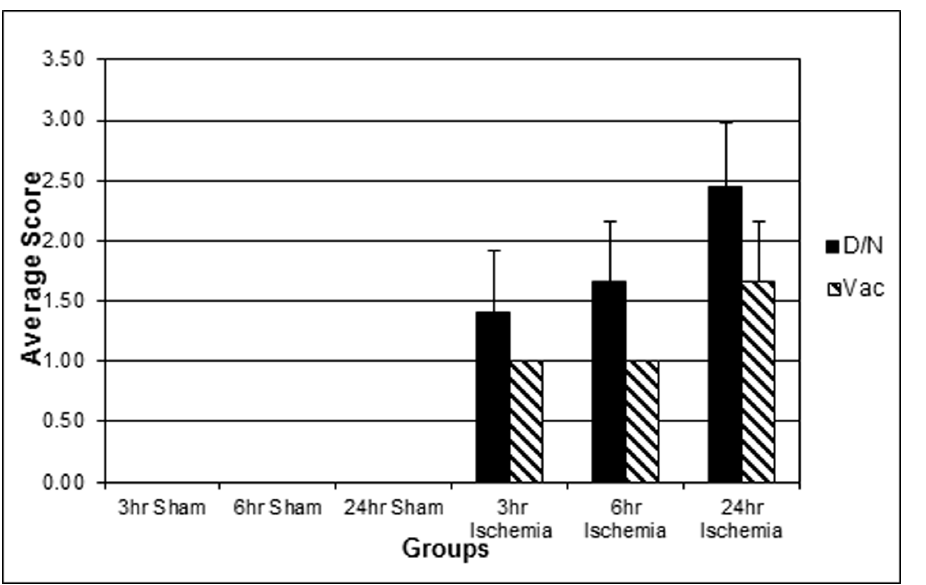
Figure 2. Distribution of average histopathology score. Kidney sections from the mice that underwent sham operation or bi-lateral renal ischemia –reperfusion were stained with hematoxilin-eosin (as represented in Figure 1). These sections were evaluated in a semi-quantitative manner for the signs of tissue injury. Degeneration, necrosis and vacuolation were not detected in the sham-operated animals while they increased in the kidneys with ischemia-reperfusion. Morphological signs of kidney injury progressively accumulated in accordance with reperfusion time. D/ N=degeneration/necrosis score; Vac=vacuolation score.